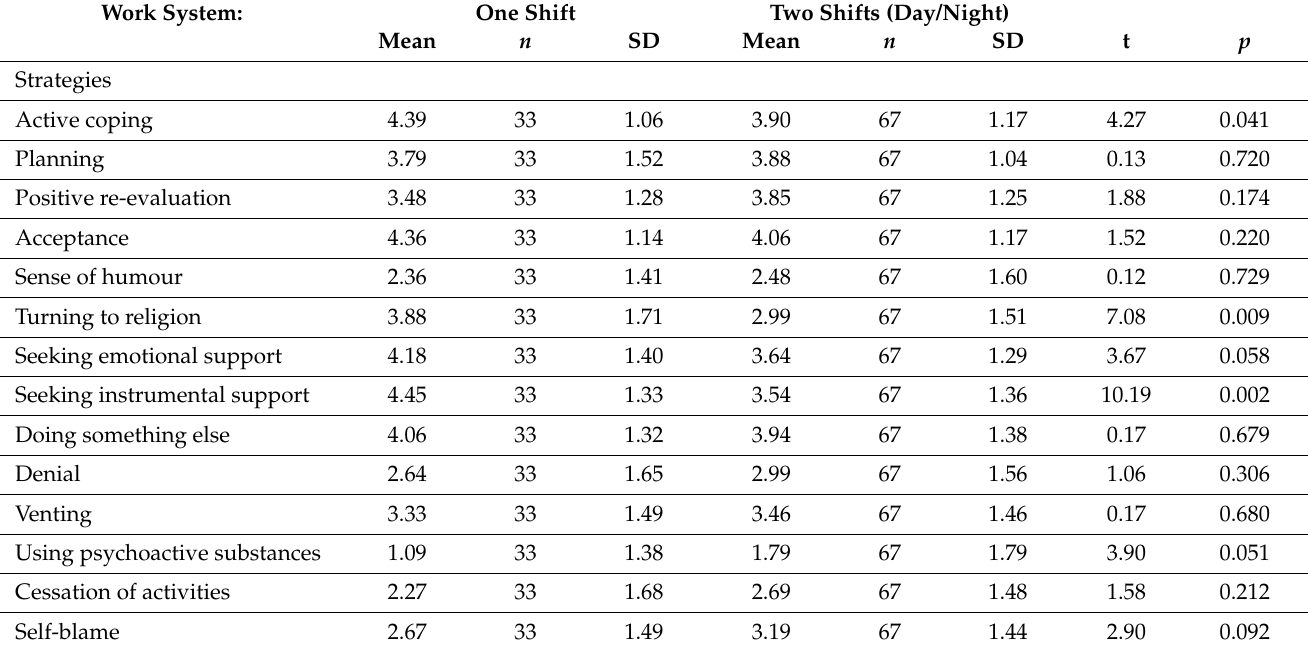
Table 2. Strategies of coping with stress used by nurses depending on the system of their